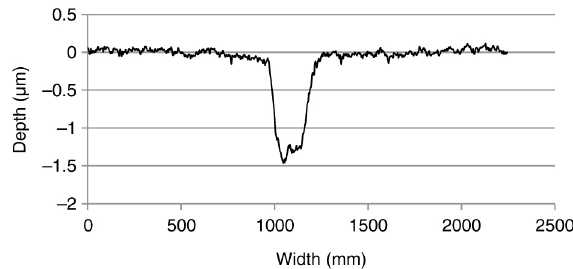
Figure 3: Trace of the wear track after the friction test.